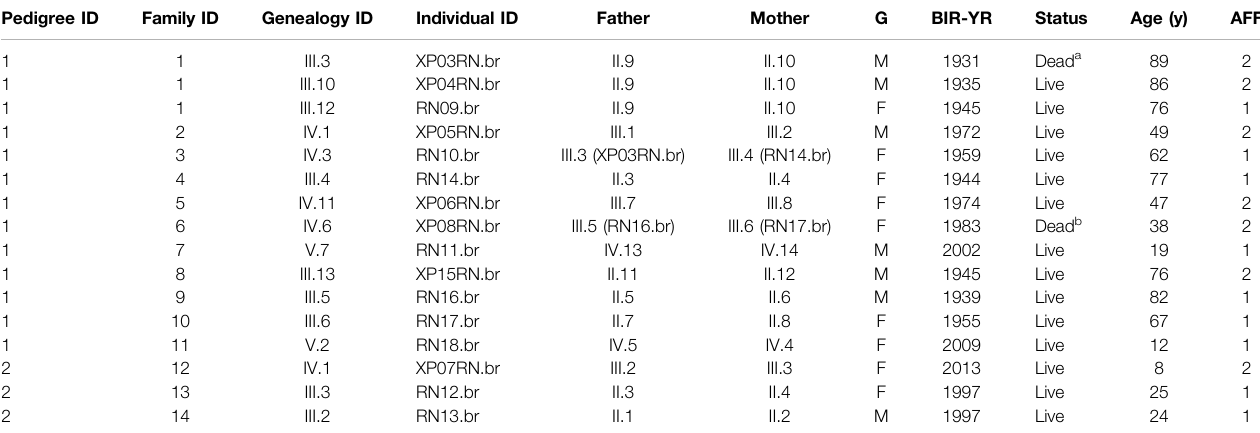
TABLE 1 | Family structure information from seven patients and nine relatives. Pedigree ID